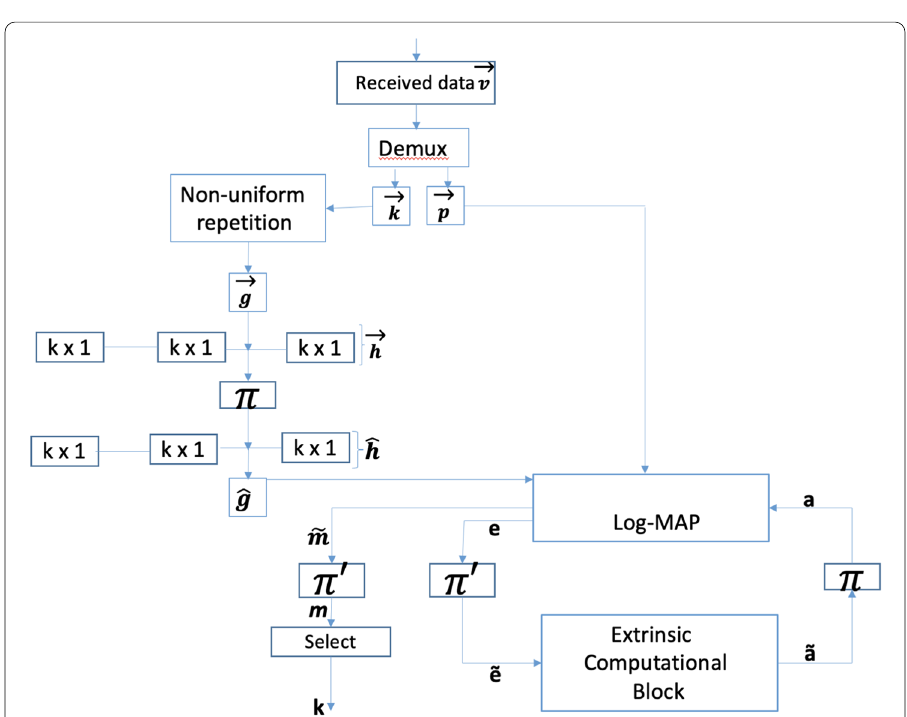
Fig. 2 Iterative decoding structure of an irregular Vector Turbo